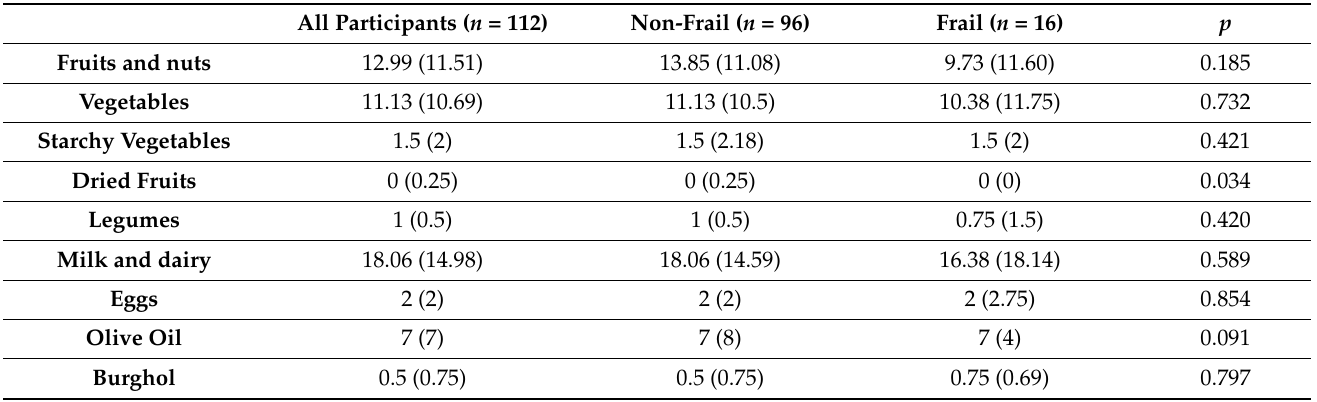
Table 2. Intake for each component of the LMD between frail and non-frail.